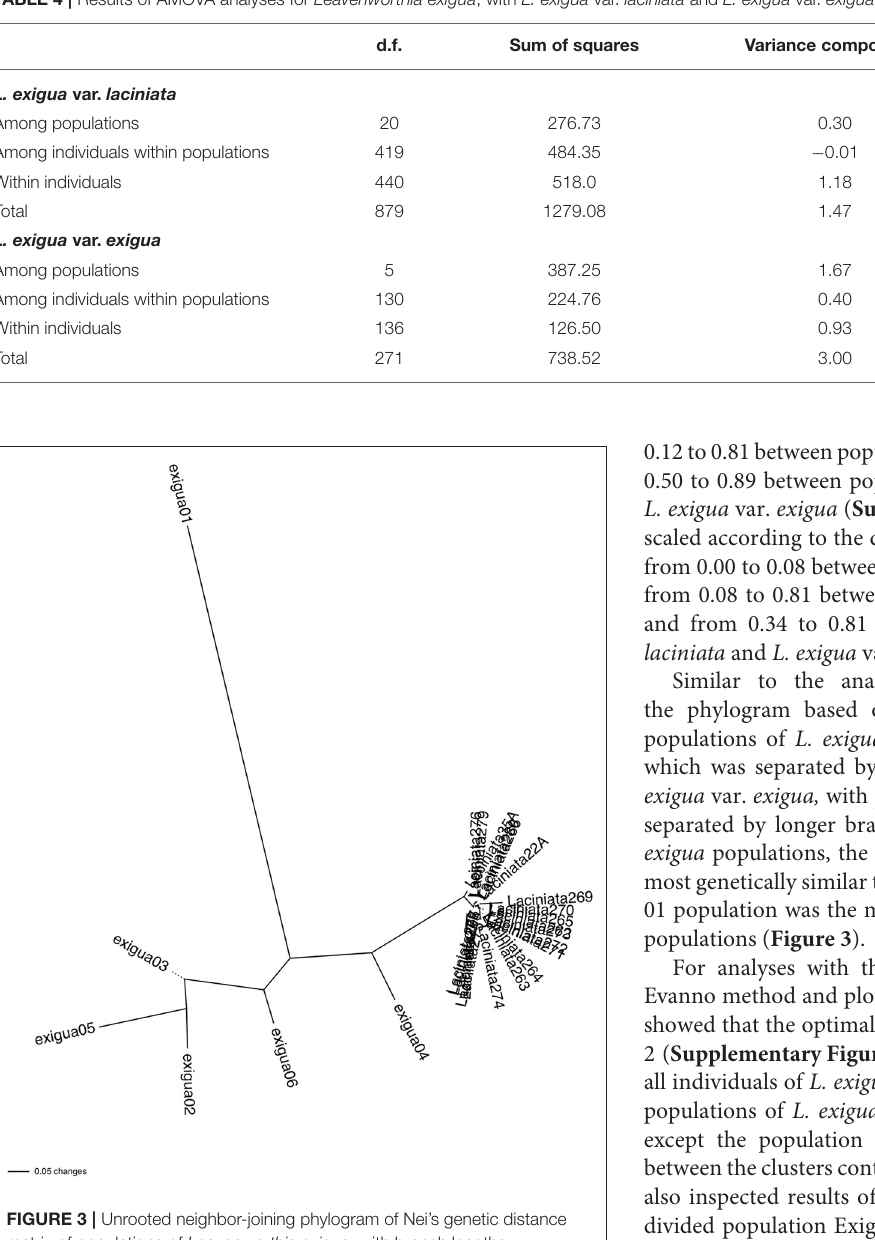
TABLE 4 | Results of AMOVA analyses for Leavenworthia exigua , with L. exigua var. laciniata and L. exigua var. exigua analyzed separately. d.f. Sum of squares Variance components